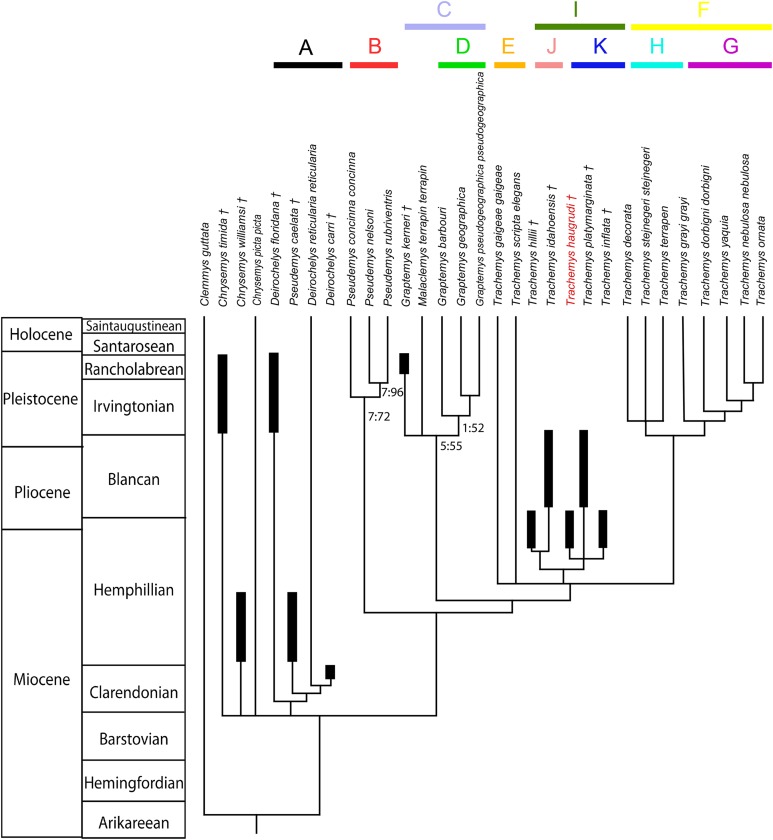
Phylogenetic relationships of deirochelyine emydids supported by this study based on morphologic data constrained by a molecular backbone.See text and appendices for details. Intergeneric relationships of modern taxa constrained based on molecular phylogenetic analysis presented by Spinks et al. (2016, fig. 5). Analysis includes the emydine Clemmys guttata as the outgroup. The tree presented represents the strict consensus tree of deirochelyine relationships found in the phylogenetic analysis of 243 characters within 31 taxa. Clades listed are called out and discussed in the text. Thickened bars indicate age ranges for fossil taxa. Tree length equals 882 steps, consistency index equals 0.409, retention index equals 0.475. Numbers beside branches provide the bremer supports (first) and the bootstrap values (second). Numbers are shown for branches with bootstrap values greater than 50. A, Clade “A”; B, Clade “B”; C, Clade “C”; D, Clade “D”; E, Clade “E”; F, Clade “F”; G, Clade “G”; H, Clade “H”; I, Clade “I”; J, Clade “J”; K, Clade “K.”